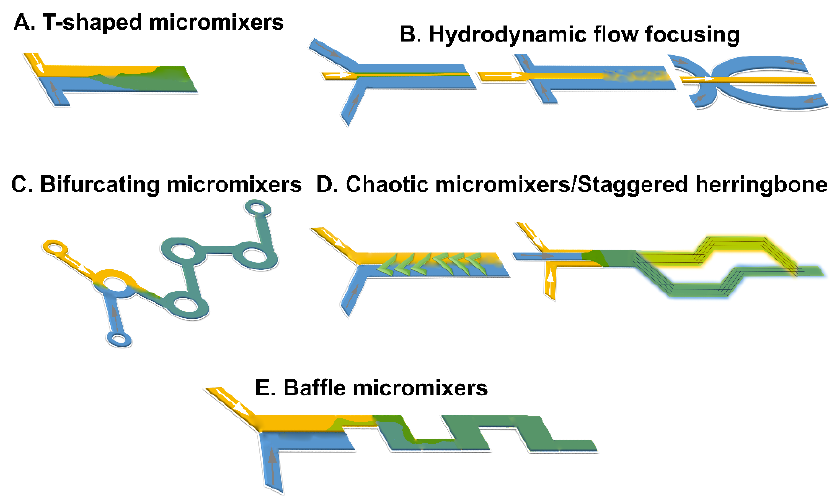
Figure 2. Summary of schematic designs of microfluidic mixers for lipid nanoparticle development : ( A ) T-shaped mixer, ( B ) hydrodynamic flow focusing, ( C ) bifurcating mixers, ( D ) chaotic, staggered micromixers, and ( E ) baffle mixers.